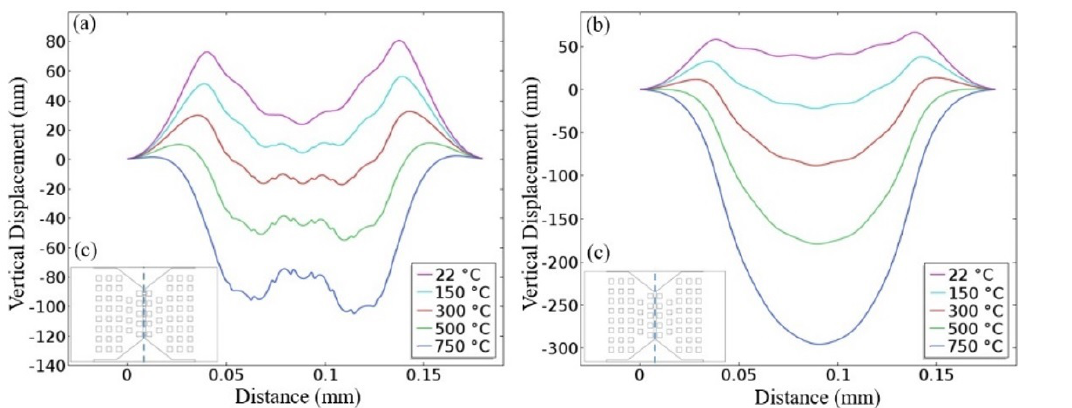
Figure 6. Simulated vertical deformation of the membranes at different operating temperatures. ( a ) Composite heater design. ( b ) D02 design. ( c ) Cut-line of the inset representing the location of the results displayed in ( a , b